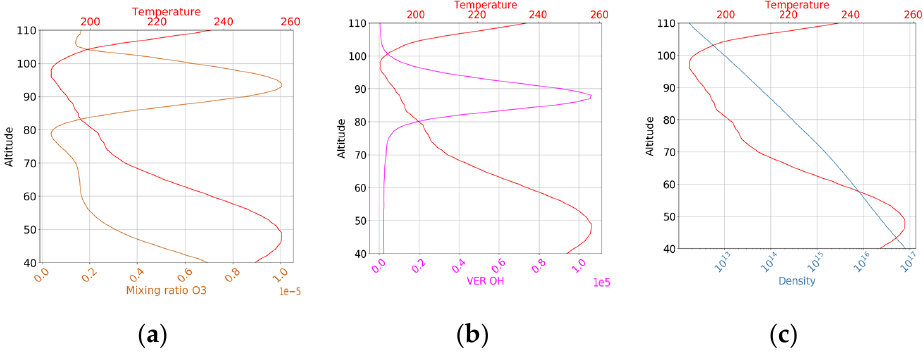
(cid:3032)(cid:3045)(cid:3034) /𝑠 , and ( c ) the atmospheric /s , and ( c ) the atmospheric (cid:3030)(cid:3040) (cid:3119) cm 3